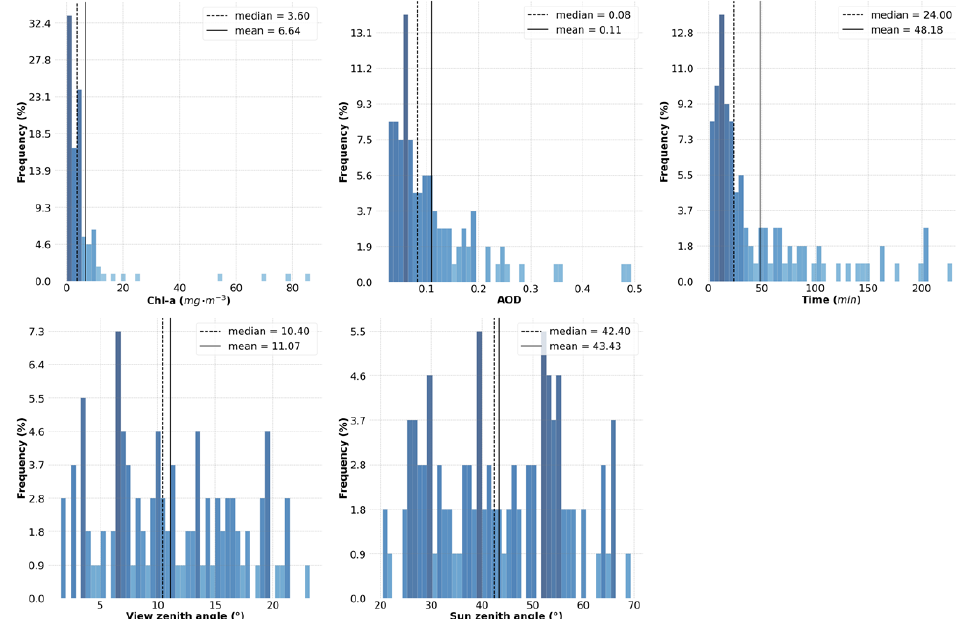
Figure 2 . Frequency distributions of estimated Chl-a concentration [32], measured AOD (550), absolute time lag between the acquisition of imagery and in situ spectra, view zenith angle, and sun zenith angle. The continuous vertical lines represent the mean value, while the dashed lines refer to the median value.